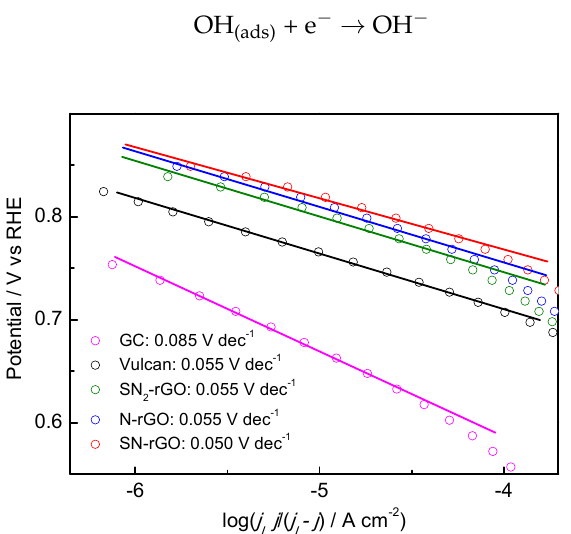
Figure 8. Tafel plots for the oxygen reduction reaction (ORR) for all employed catalysts in 0.1 M NaOH.